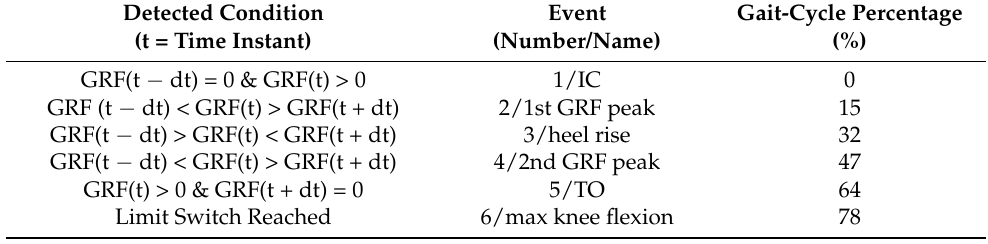
Table 1. Detection of gait-cycle events based on GRF-vertical-component measurements and the knee-flexion limit switch.